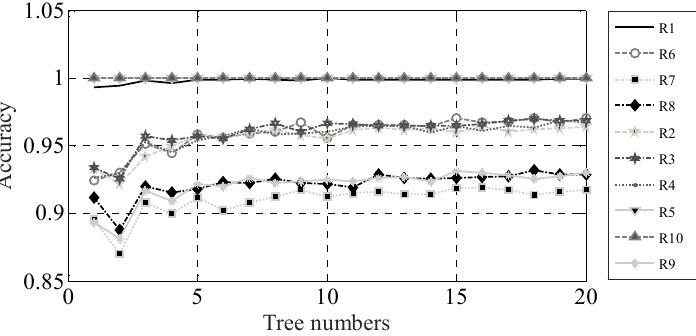
Figure 8. Random forest (RF) performance in function of adjustment of its hyper-parameters.